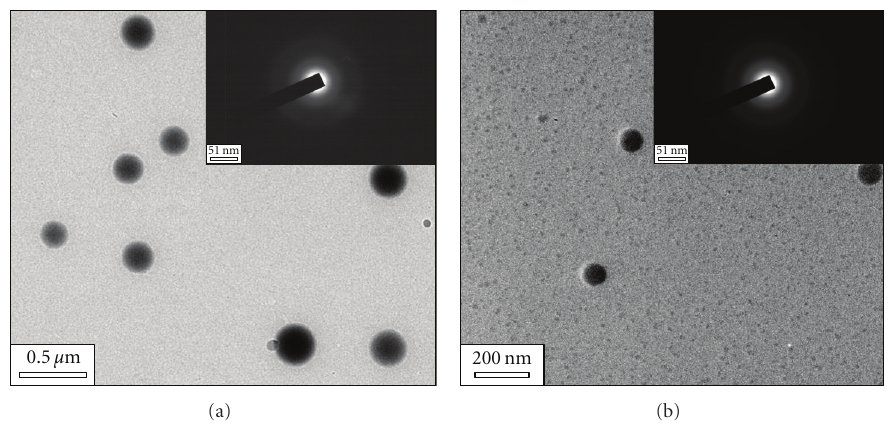
Figure 2: TEM images of IL-SiO 2 . (a) IL-SiO 2 (1/1), (b) IL-SiO 2 (2/1).